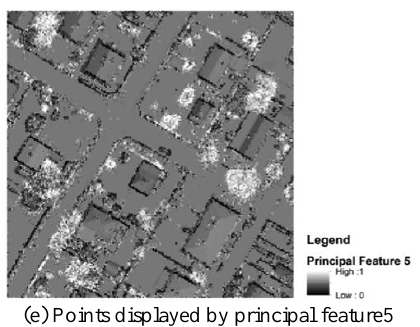
Figure 3. Point cloud displayed by 5 principal features This paper takes 30% data as training data, and 70% as test data to evaluate the classification result. Figure4(a) is the reference classification result and Figure4(b) is the classification result achieved by this paper. Table1 indicates overall accuracy and misclassified rate in each class. The ground is well classified, the overall accuracy reaches 97%. Building classification overall accuracy is 88.3%, a few building points are misclassified into ground. However the algorithm has difficulty in classifying vegetation and ground, and a amount of vegetation are classified into buildings. Other points such as construction and cars can hardly be detected.